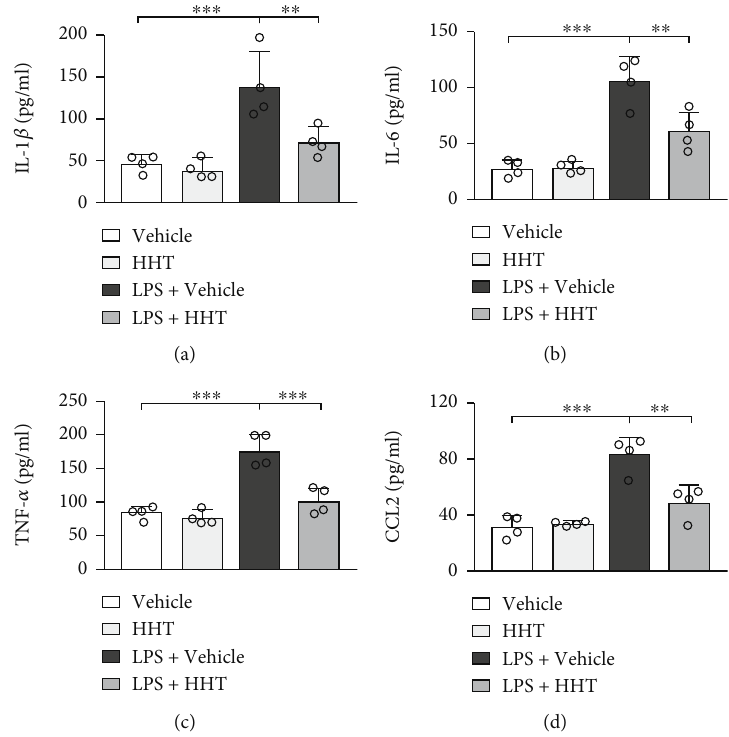
Figure 4: HHT inhibits the activation of macrophages induced by LPS in vitro . Cultured RAW264.7 cells were stimulated with 1 μ g/mL LPS along with vehicle or 50 nM HHT for 6 hours. And the medium was harvested for the ELISA of IL-1 β (a), IL-6 (b), TNF- α (c), and CCL2 (d). Error bar represents mean ± SD . ∗∗ p < 0 : 01 ; ∗∗∗ p < 0 : 001